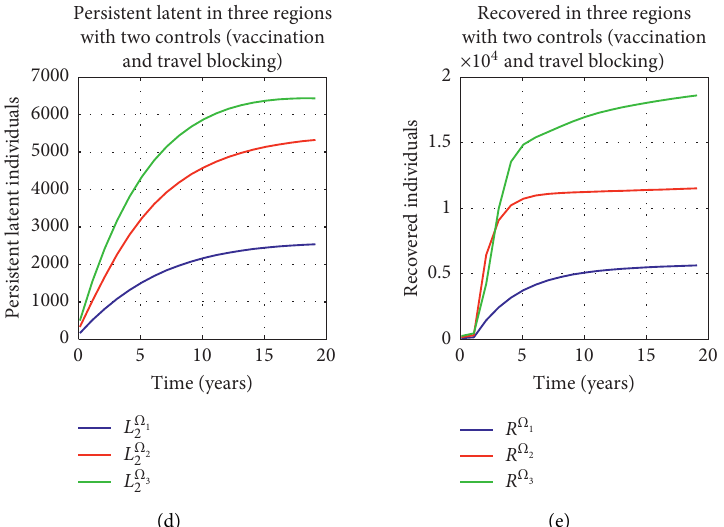
Figure 5: Comparison for each state variable for the three regions with BCG vaccination and travel-blocking control.